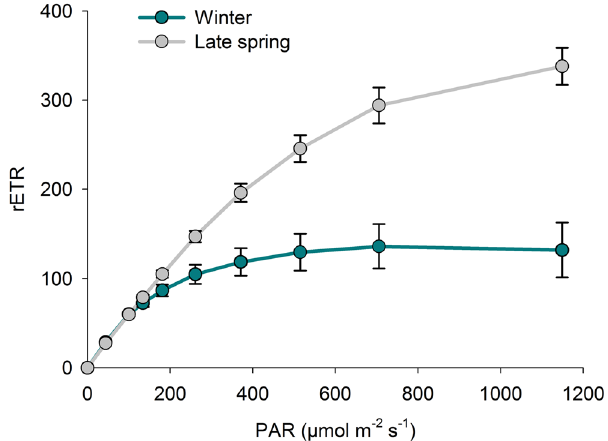
Figure 3. Representative light-response curves of relative electron transport rate of PSII (rETR) measured on Z . noltei leaves (collected in winter and late spring) at sampling site 5 (N = 5, mean ±